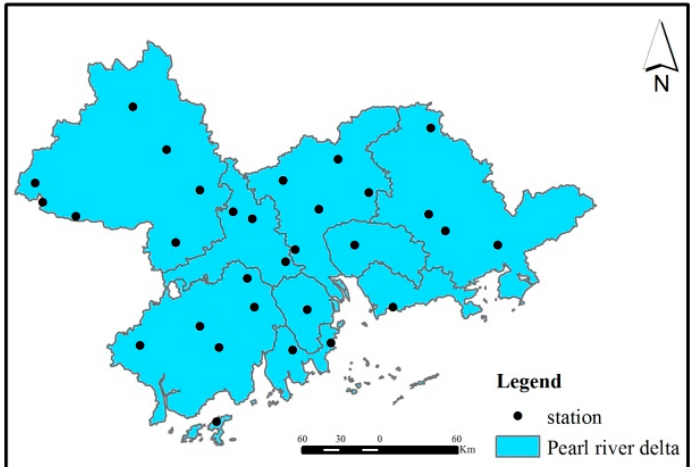
Figure 2. Station of climatic factors in the PRD region.